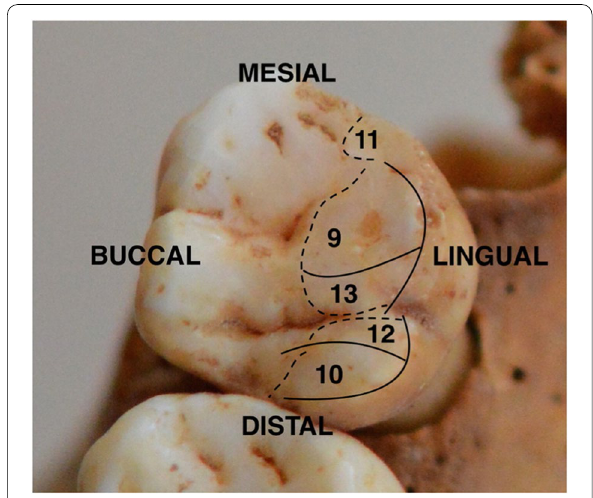
Fig. 1 Microwear on grinding facet (Scott and Halcrow